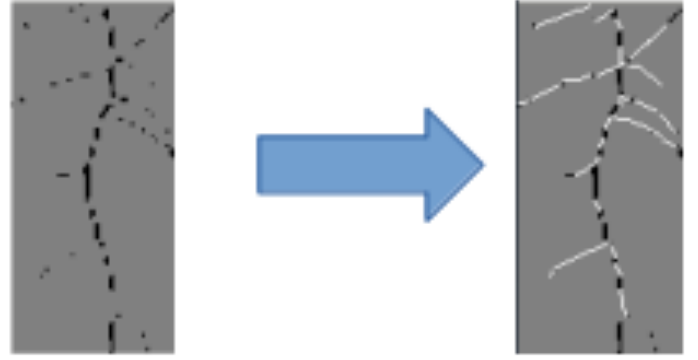
Figure 12. Example of postprocessing a patch of our segmentation results from Figure 11 using PIL. The gaps along the segmented lateral and main roots are closed using white